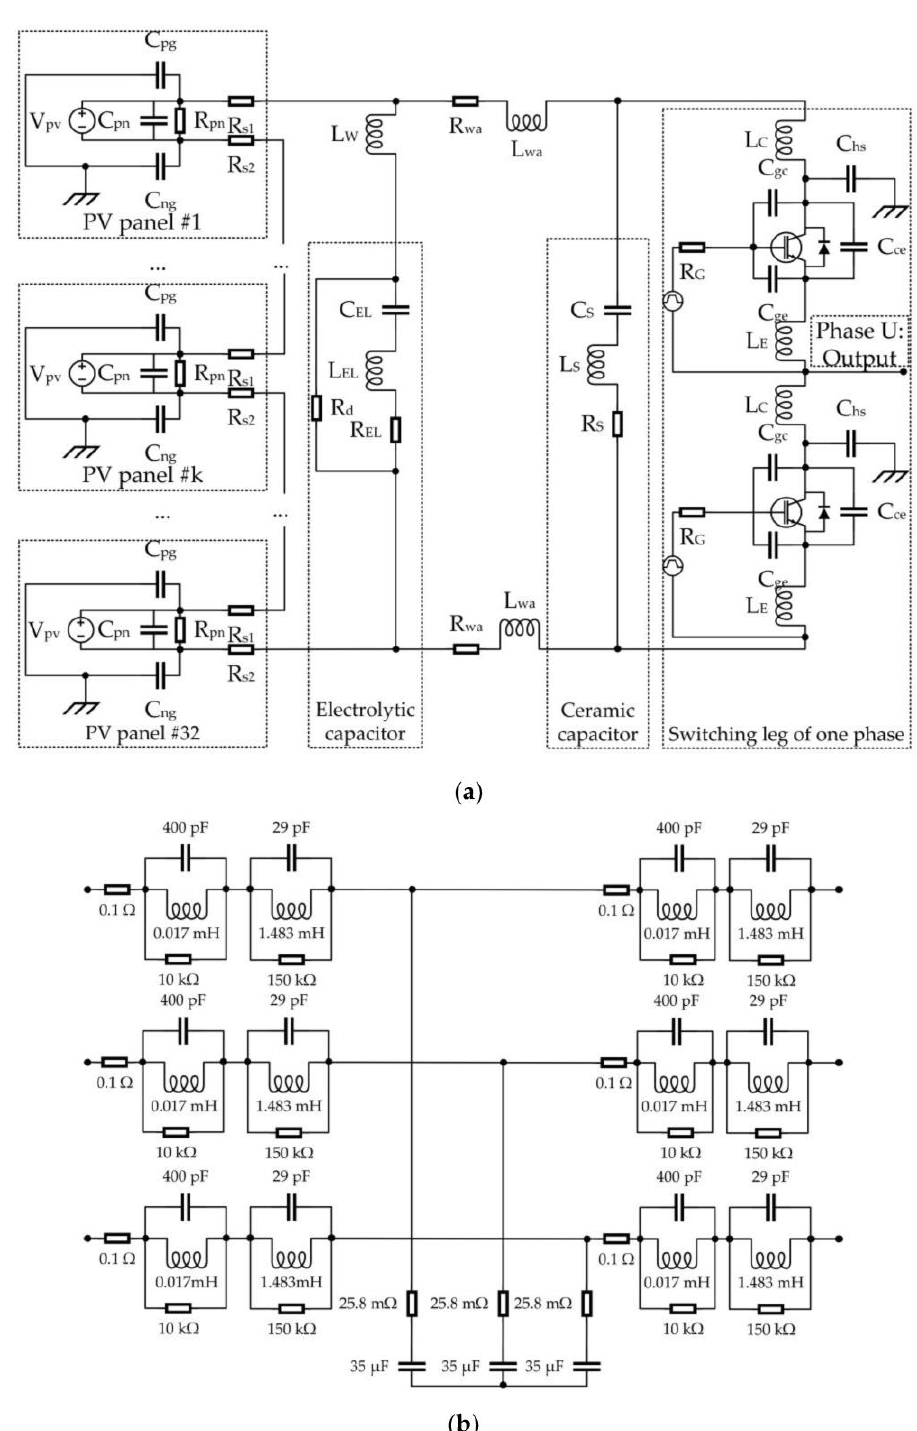
Figure 3. Circuit model of ( a ) the inverter with input capacitors and ( b ) the LCL filter.